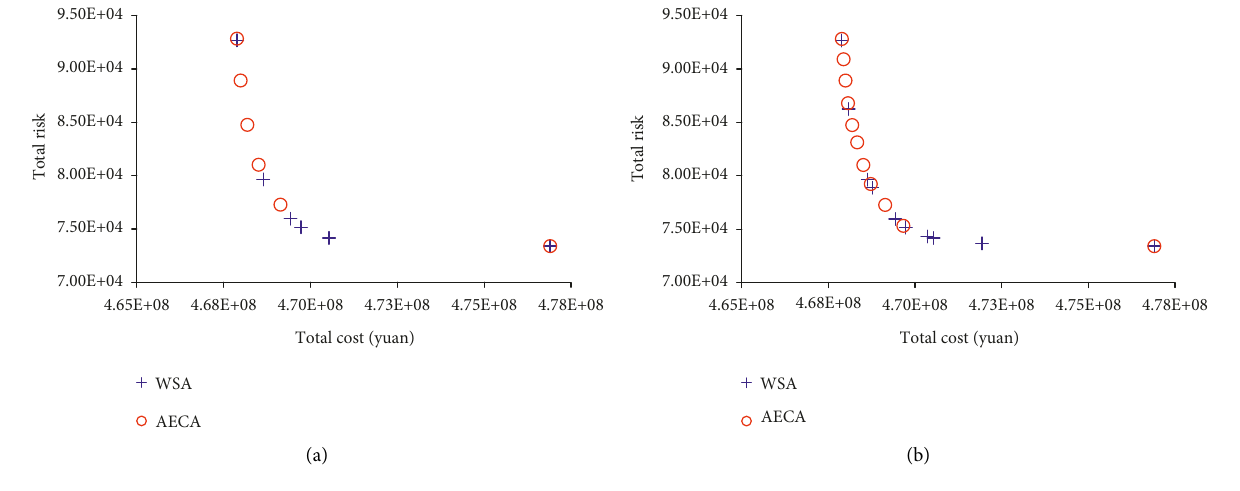
Figure 5: Comparison of approximate nondominated